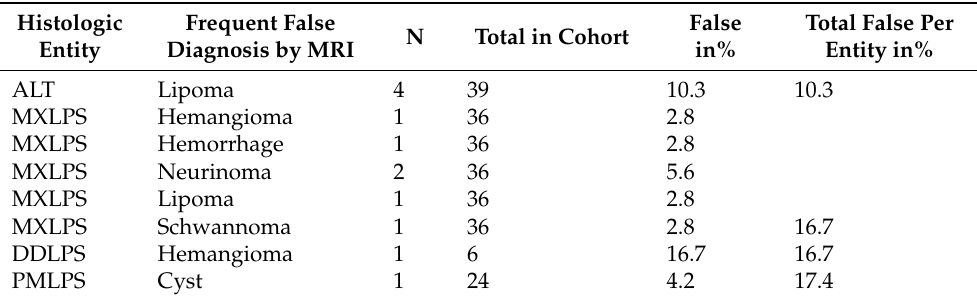
Table 1. Entities of tumors under-diagnosed by MRI. In total, 12 tumors were under-diagnosed regarding their malignancy by